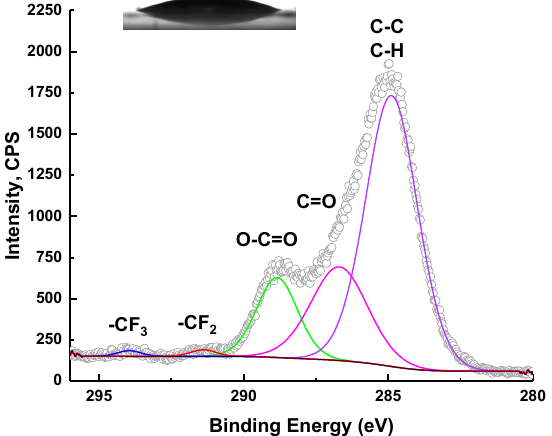
Figure 7. Static contact angles of HFBMA NP thin films correlated with R h values of NPs.